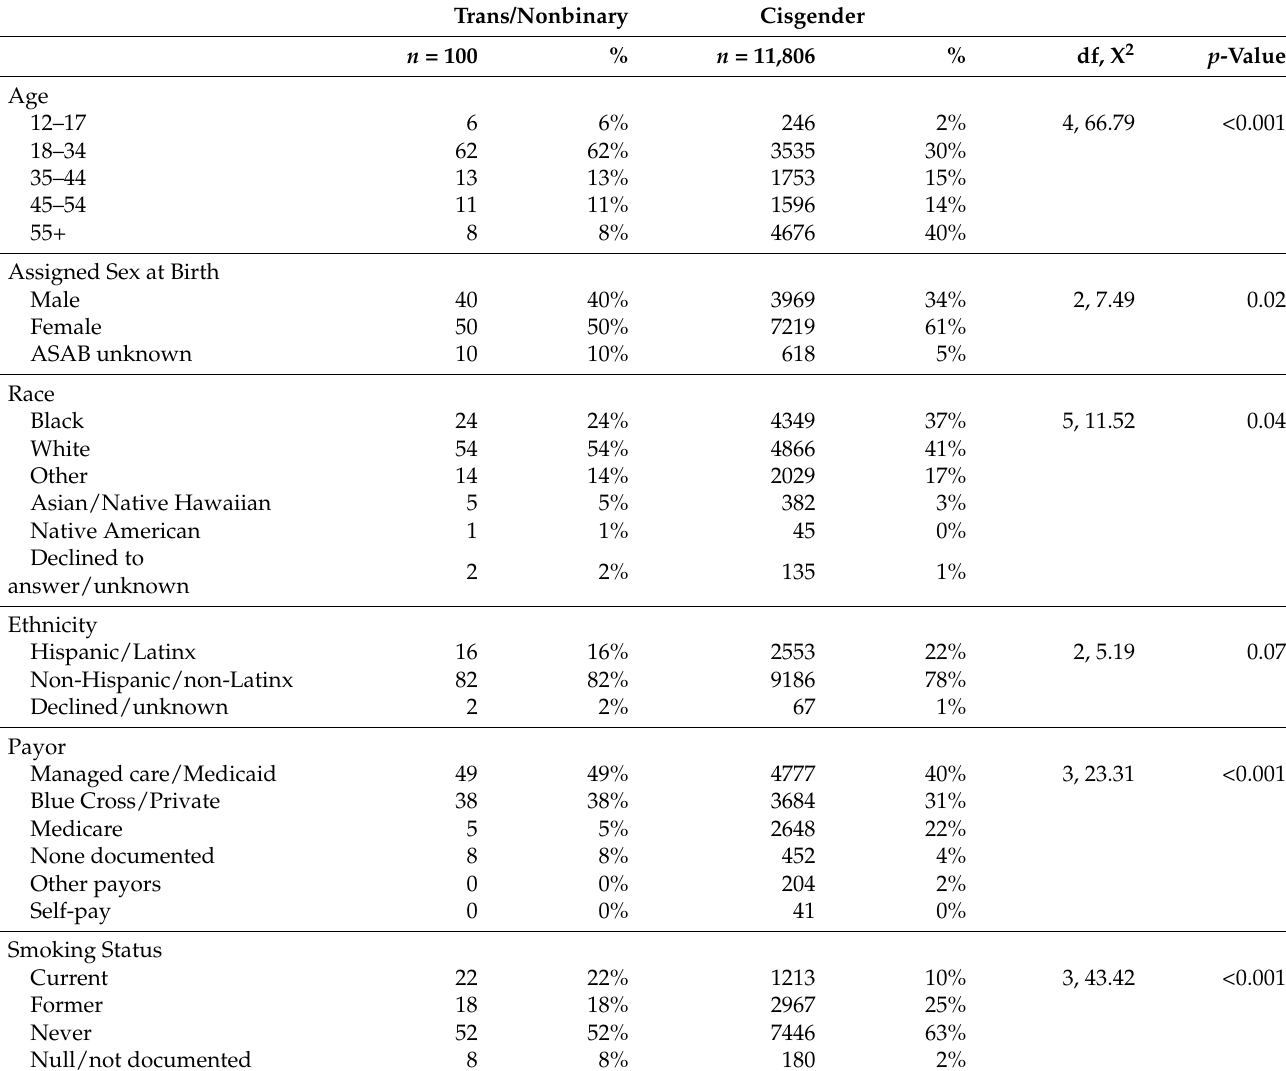
Table 4. Demographic traits and smoking status of unique hospital patients ( ≥ age 12) in 2020, comparing patients with trans/NB GI data ( n = 100) to patients with cisgender GI data ( n =